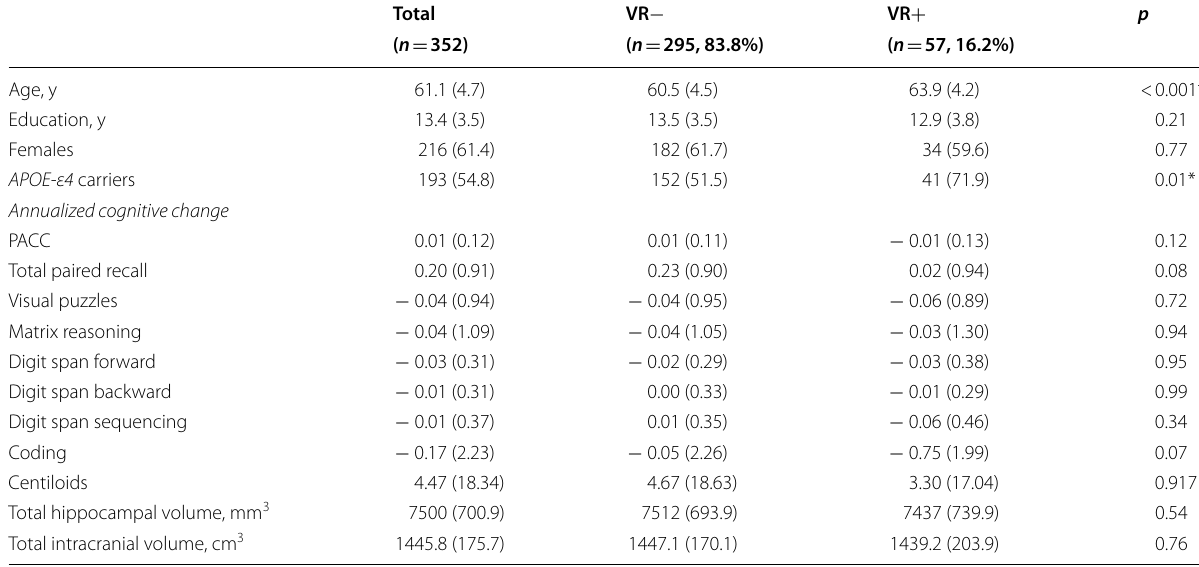
Data are expressed as mean and SD or number of participants and percentage, as appropriate PACC Preclinical Alzheimer’s Cognitive Composite, TIV total intracranial volume, VR visual read